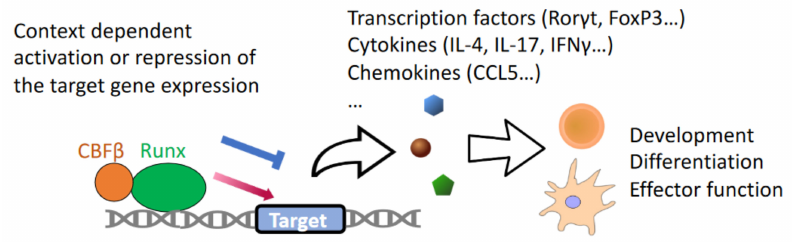
Figure 1. All 3 RUNX proteins (RUNX1, RUNX2 and RUNX3) dimerize with CBF β to stabilize RUNX and mediate RUNX DNA binding activity. RUNX-CBF β complexes bind to cis -regulatory elements in their target loci and activate/repress the expression of target genes which mainly encode various transcription factors, cytokines and chemokines. The transcriptional regulation of RUNX these target genes collectively function to regulate the development, differentiation and function of immune